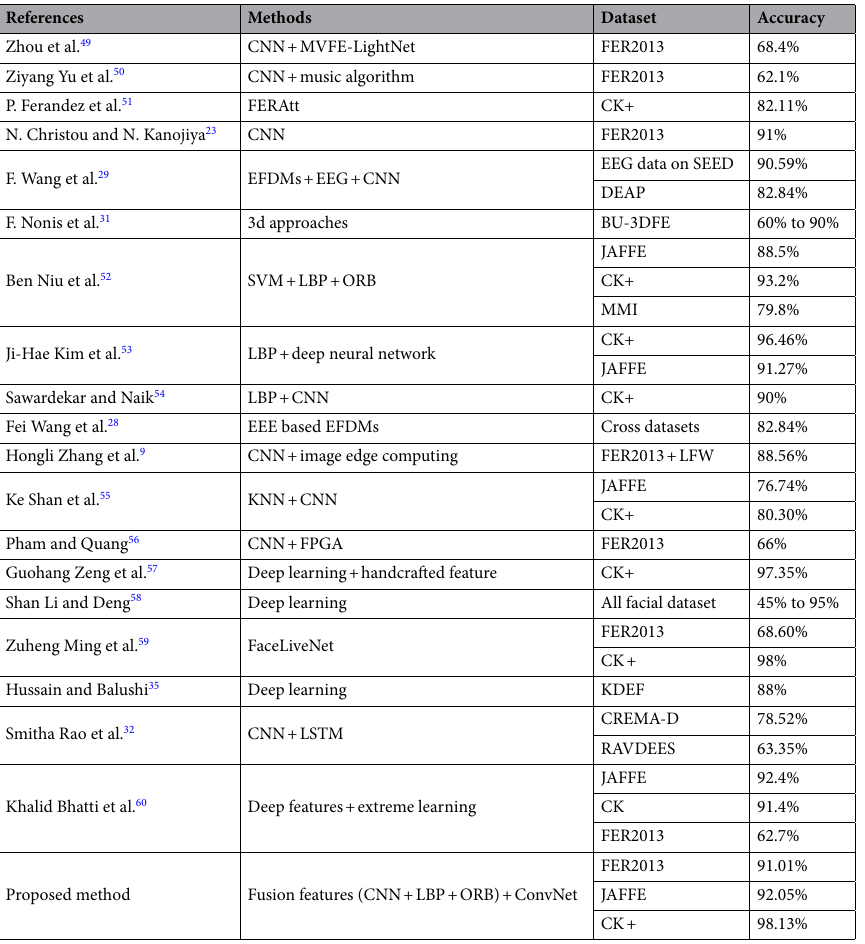
Table 6. Comparison among existing methods in the Facial Emotion